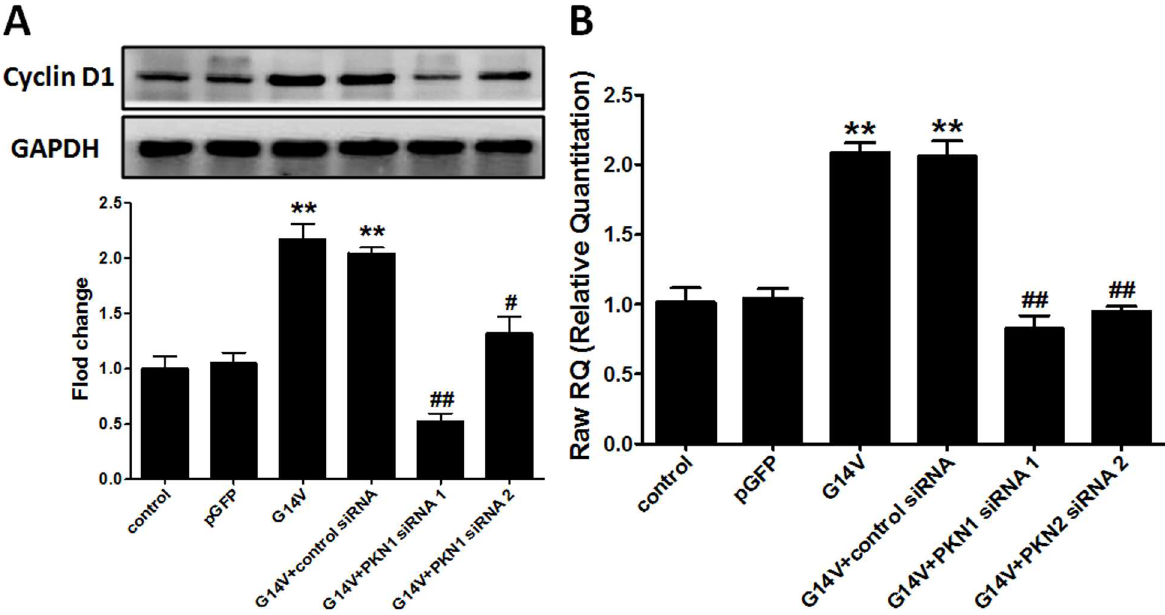
Fig 5. RhoA regulates cyclin D1 expressionthrough PKN1. After Lipofectamine-mediatedtransfection of huESCs with 1.5 μ g/ml G14V plasmid, 1.5 μ g/ml pGFP control plasmid, and 60 nM specific PKN1 siRNA for 48 h, cyclin D1 protein (Western blot, A) and mRNA expression(real-time PCR, B) was detected. The data are presentedas the mean ± SD of three independent experiments; an unpaired, two-tailedStudent’st-test was used to assess significance: ** P < 0.01versus control, # P < 0.05versus G14V + control siRNA, ## P < 0.001 versus G14V + control siRNA.